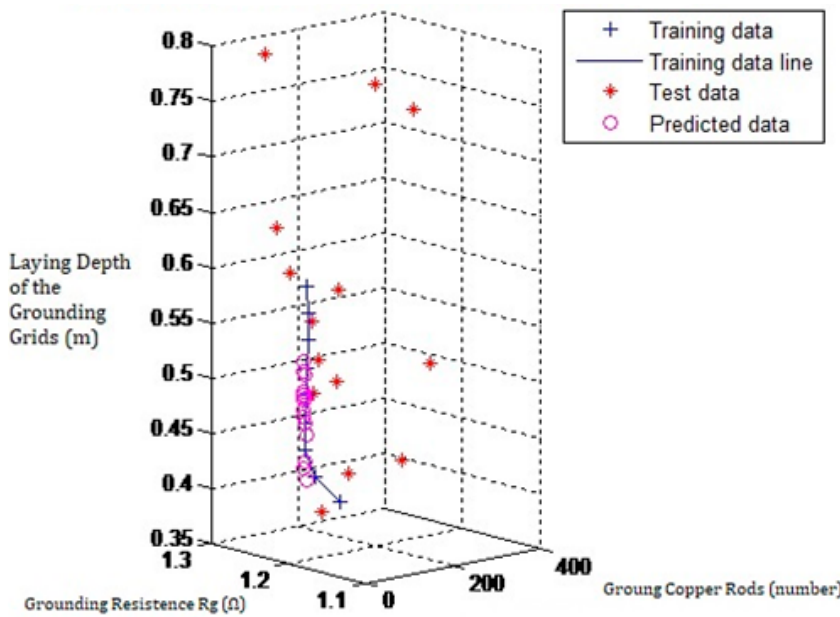
Figure 9. Prediction line calculation results by an RBF neural network.